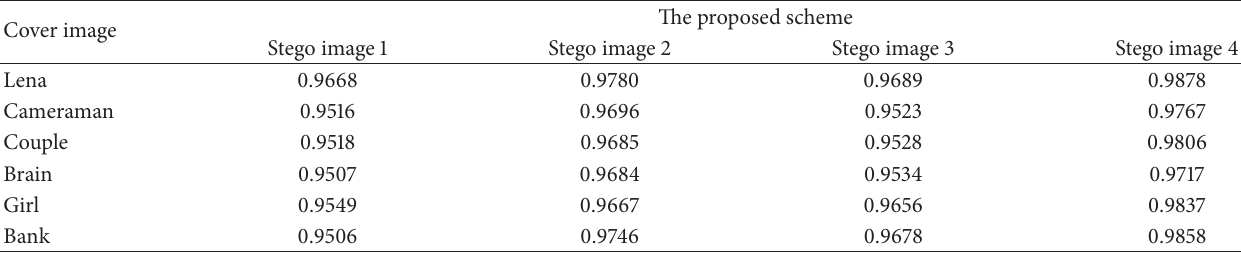
Table 8: SSIM of stego images.